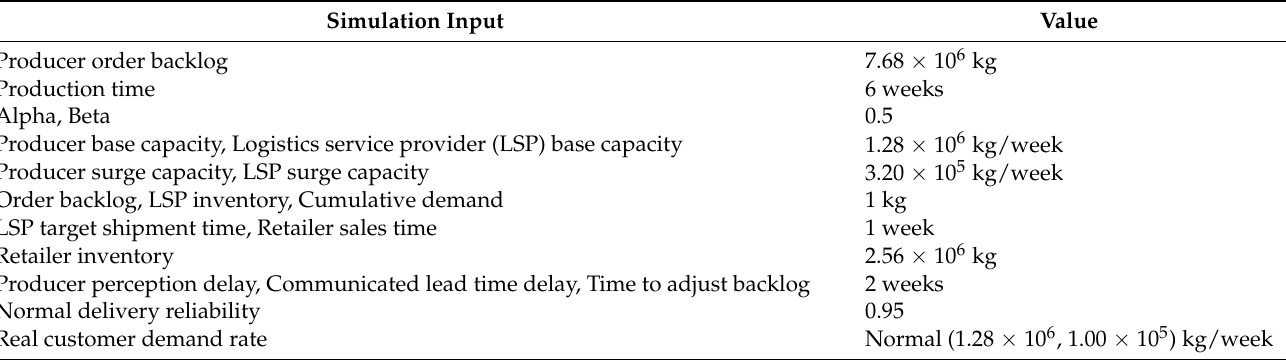
Table 1. Simulation inputs with